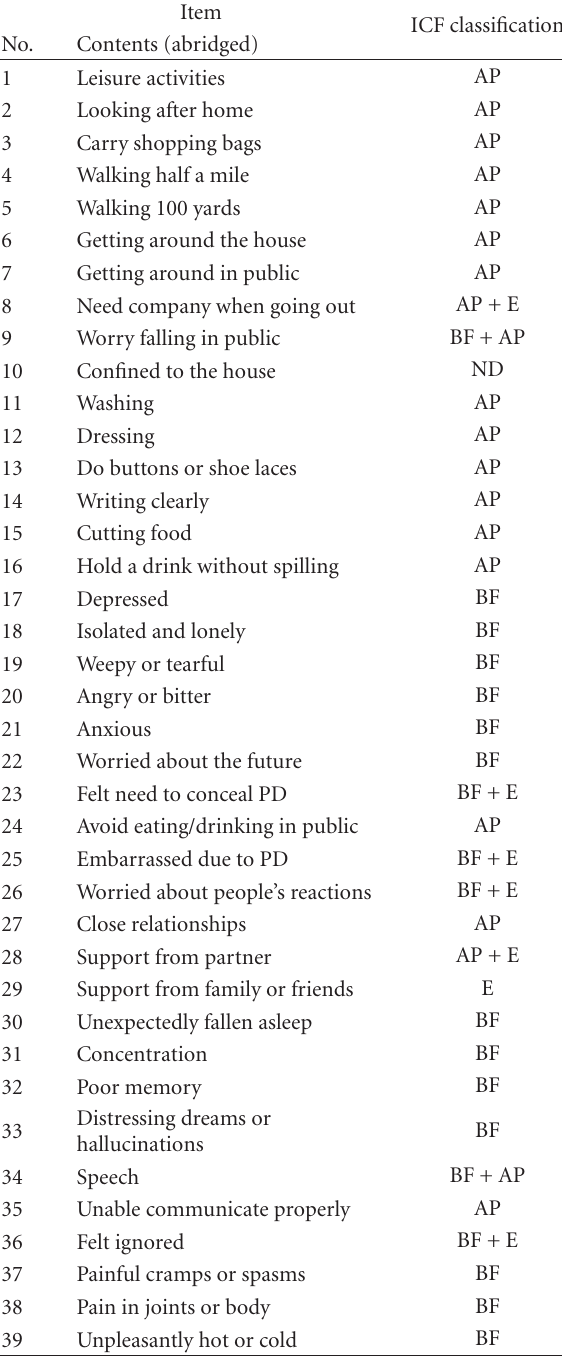
Table 2: ICF classification of PDQ-39